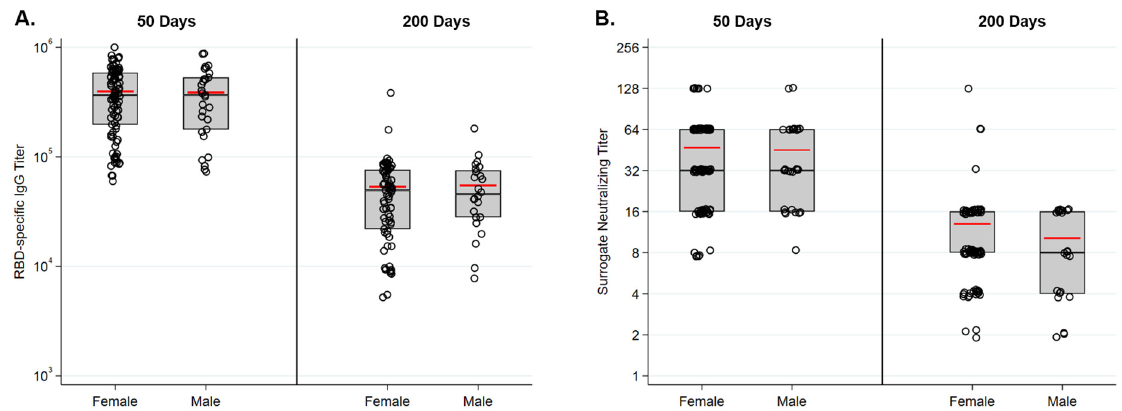
Figure 4. Antibody responses to vaccination are similar in males and females. ( A ) RBD-specific IgG titers as measured by ELISA were similar in females and males 50 and 200 days following immunization. ( B ) SARS-CoV-2 surrogate neutralizing titers were similar in females and males 50 and 200 days following immunization.